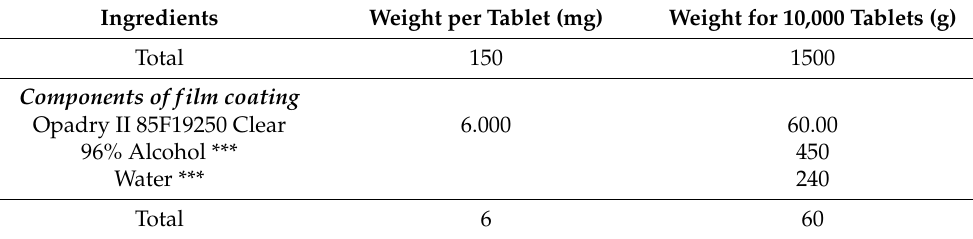
Table 1. Cont . Ingredients Weight per Tablet (mg) Weight for 10,000 Tablets (g) Total 150 1500 Components of film coating Opadry II 85F19250 Clear 6.000 60.00 96% Alcohol *** 450 Water *** 240 Total 6